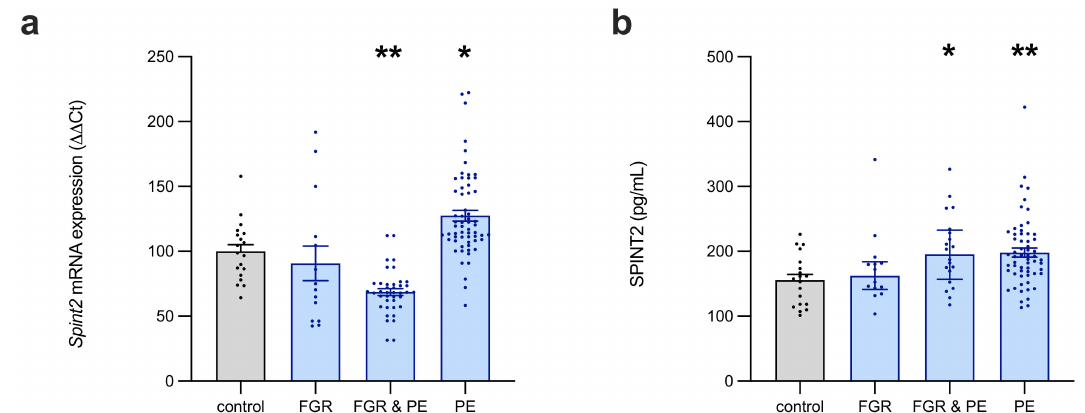
Figure 1. SPINT2 expression in placentas of patients with established placental disease. Compared to preterm controls, SPINT2 mRNA expression ( a ) was not altered in placentas from normotensive pregnancies affected by foetal growth restriction (FGR), but it was significantly decreased in those from pregnancies compromised by concurrent preeclampsia (PE) and FGR, and increased in preeclamptic placentas of AGA infants. SPINT2 protein expression ( b ) in these same placentas was also not changed in FGR-affected normotensive pregnancies, but was significantly elevated in all PE cases (with and without FGR). Each data point represents an individual patient sample; data are expressed as median ± IQR; * p < 0.05, ** p <